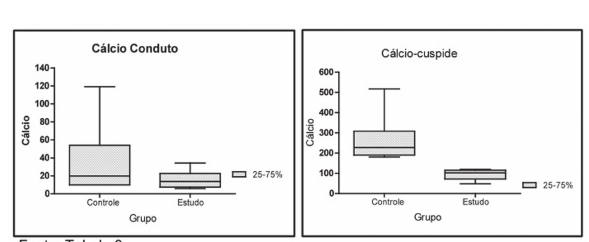
Fig. 4 – Gráficos com os valores de cálcio medidos nos condutos valvares e nas